Question: What style of plot is this figure drawn as?
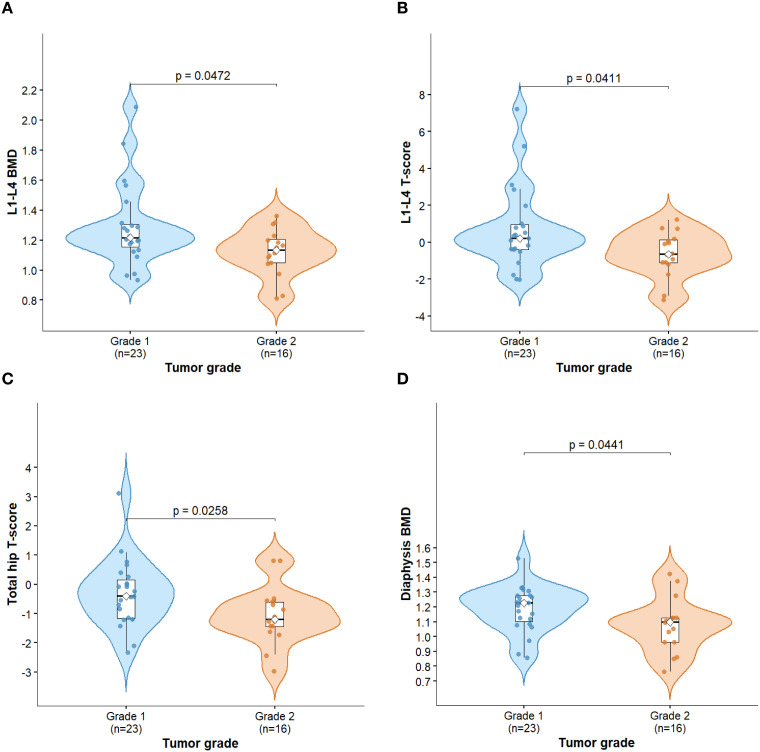
Answer: box